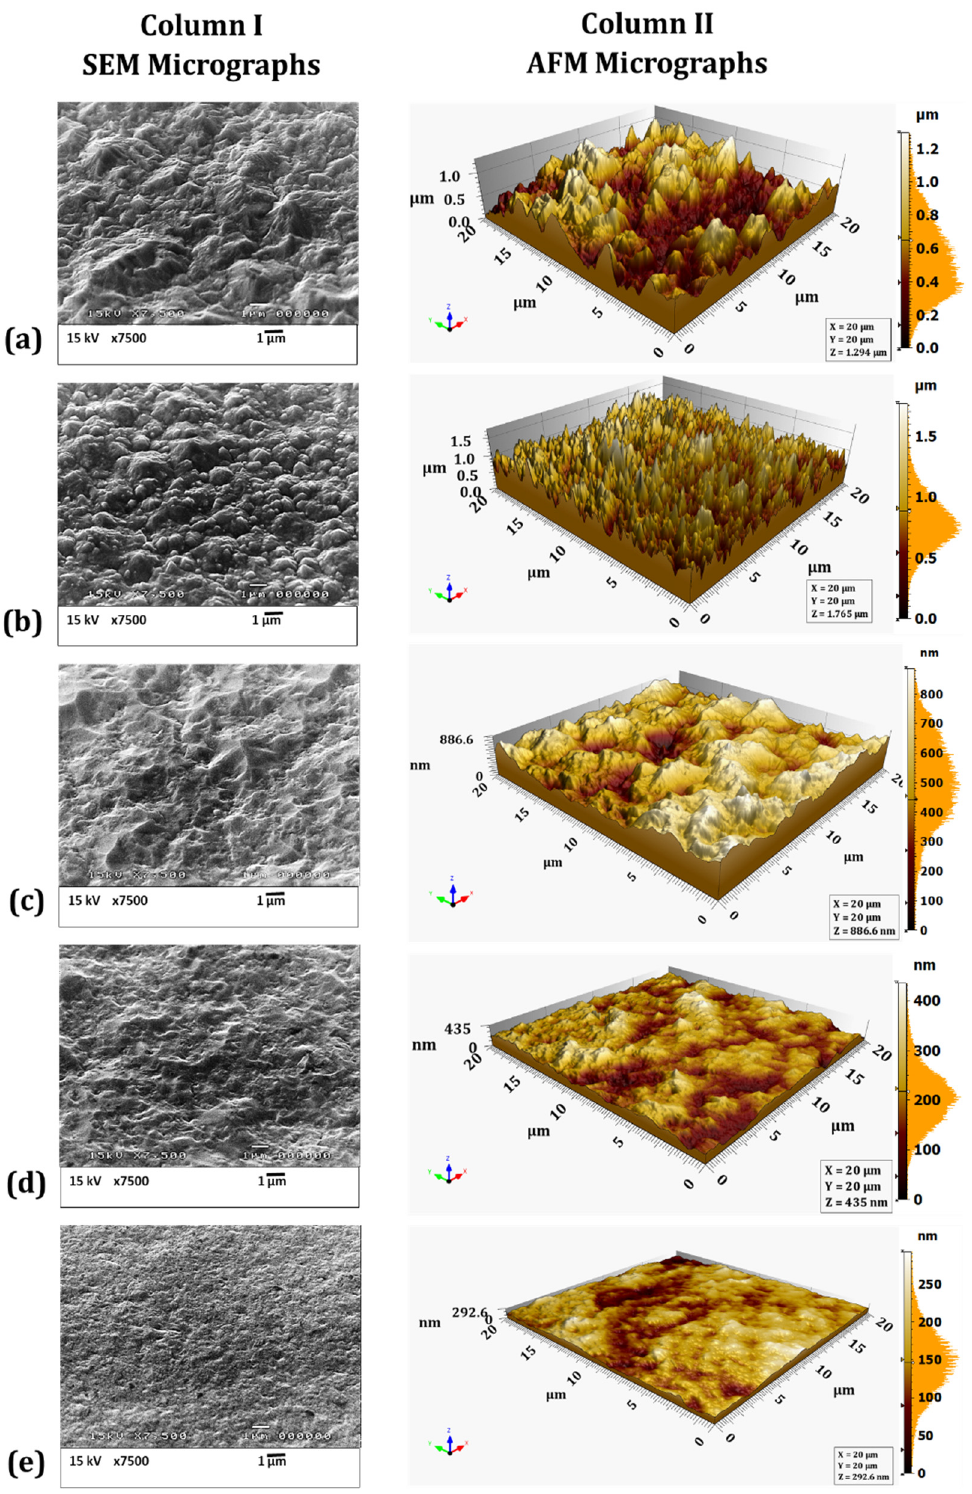
Figure 7. SEM micrographs with a magnification of 7500 (Column I) and AFM micrographs with a scan area of 20 µm × 20 µm (Column II) of eNi coating samples electrodeposited at 50 mA/cm 2 , pH 4, 45 °C, 60 min with cathode at x = 40 mm from vortex core at different BHD by varying flow velocities v ; ( a ) 0 cm/s; ( b ) 12 cm/s; ( c ) 22 cm/s; ( d ) 32 cm/s; and ( e ) 42 cm/s.